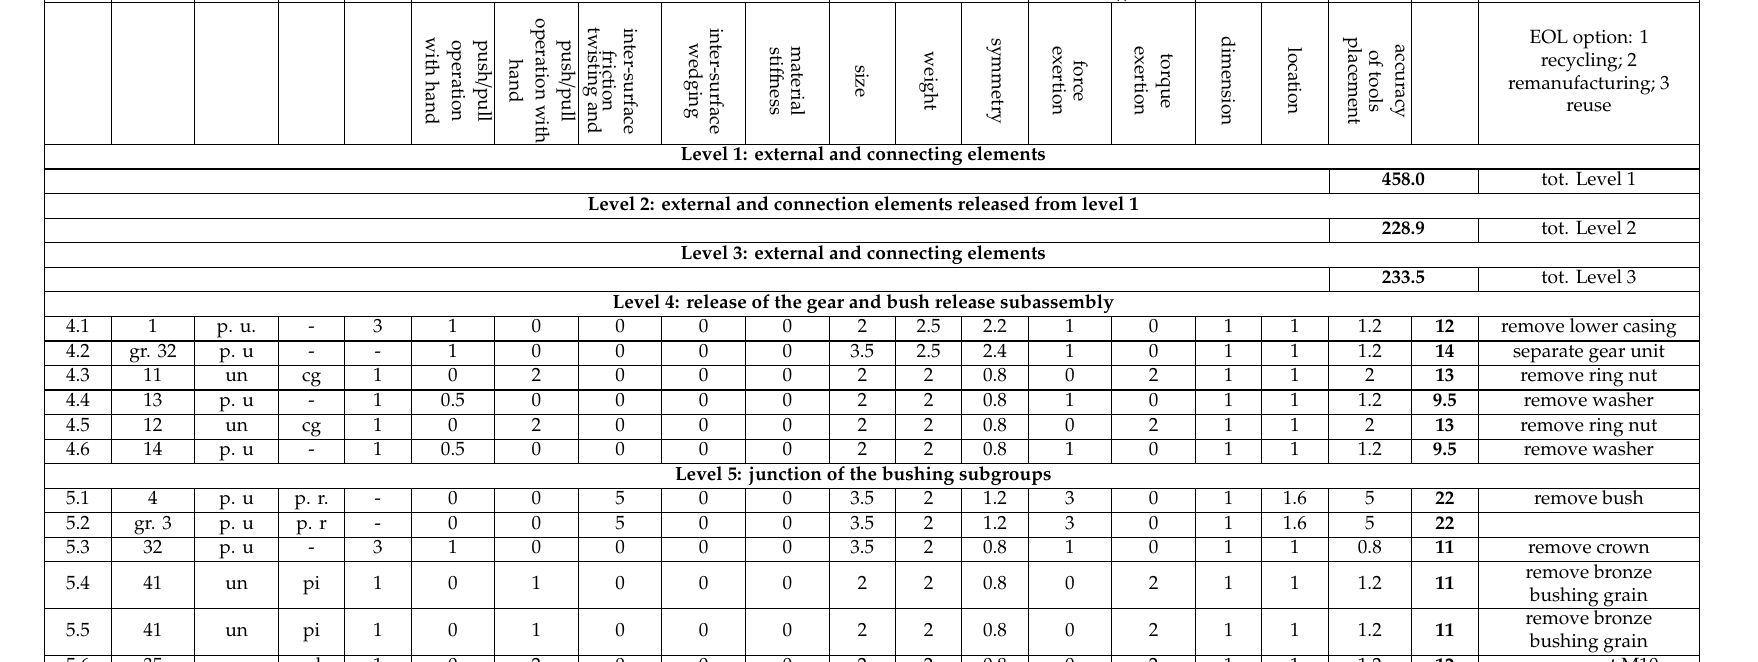
Table A1. Time calculation with Jianjun method. Take into consideration that the most external dismantling levels focus on the connecting elements, which have no di ff erent way of being treated according to the algorithm. They must all be removed and therefore, to avoid redundancy, the first disassembly levels are now omitted. Assume, therefore, to consider the mechanism as it appears at the beginning of level 4 of the previously described algorithm. T a s k N o